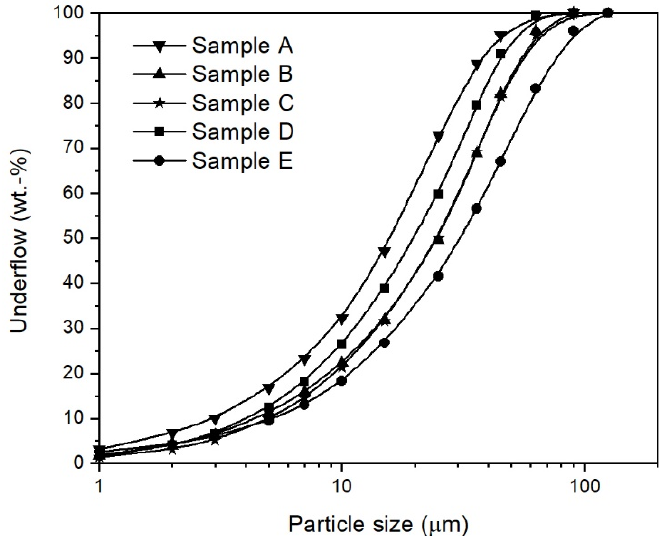
Figure 1. Particle size distributions of typical iron ore ultra-fines.